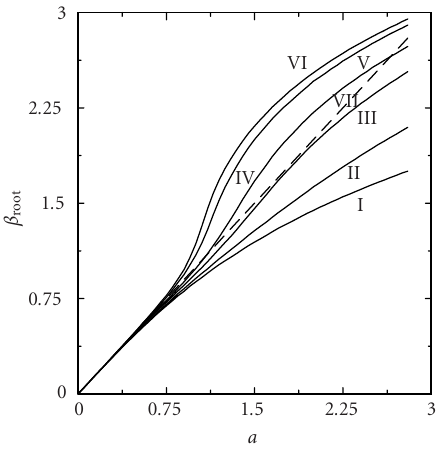
Figure 4.4. The variation of β root as a function of the parameter a , for various values of the nonin- tegrability parameter ν . This is obtained from the exact calculation. For this figure, (cid:7) H 0 = constant, x 0 = 0 . 0, and λ = 1. Curve I: ν = 0 . 0, curve II: ν = 0 . 10, curve III: ν = 0 . 40, curve IV: ν = 0 . 75, curve V: ν = 0 . 90, and curve VI: ν = 1 . 0. Curve VII: the dashed curve is the straight line β